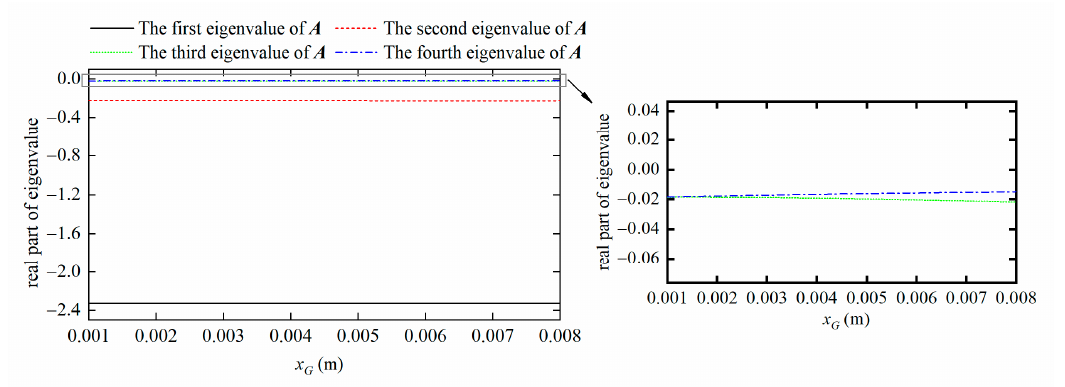
Figure 16. Motion stability with changing x G .